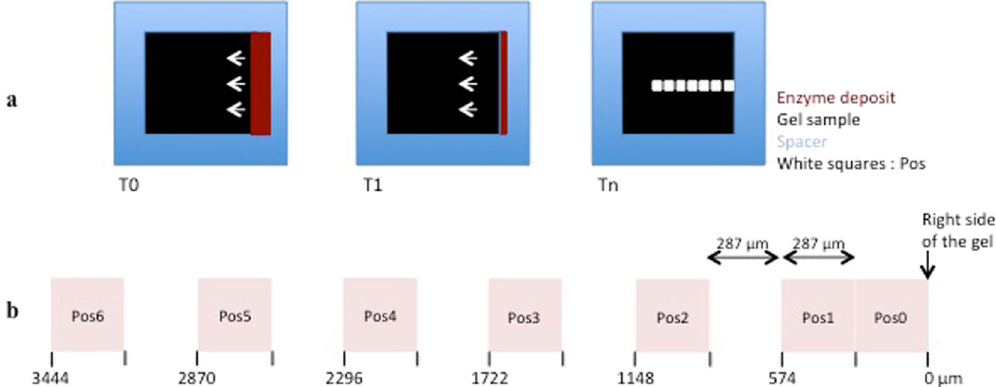
Figure 2. Definition of the regions of interest. ( a ) Schematic top view of enzyme diffusion (maroon) inside the gel sample (black) and definition of the regions of interest, referred to as Pos for Position (white squares). Three time points are represented: at T0, the channel is full of enzyme (maroon); at T1, the enzyme diffuses into the gel according to the white arrows; at Tn, the channel is empty. ( b ) From the deposit point of the enzyme (right side of the gel), the 2 first Pos corresponded to the two first fields at magnification x40, the next ones corresponded to 1 field over 2. The 7 positions were numbered from Pos0 to Pos6. Values below the positions are the distance from the deposit